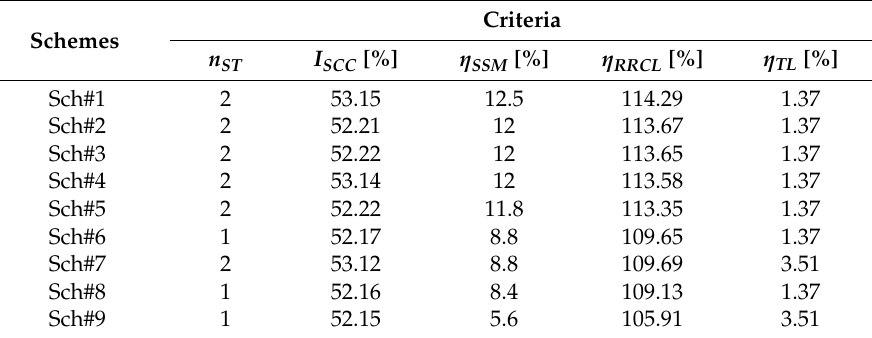
Table 4. Criteria of each feasible scheme in Case